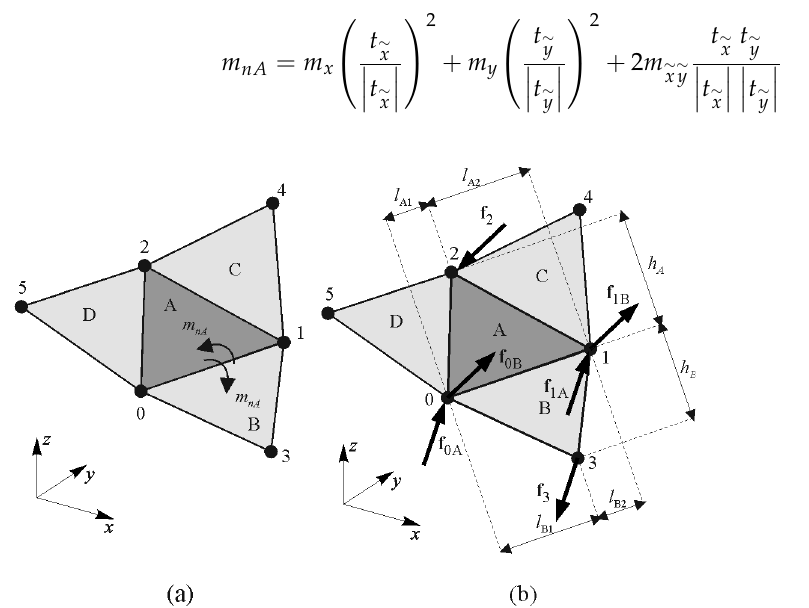
Figure 5. Forces resulting from bending carrying mechanism: ( a ) bending moment on the observed edge; ( b ) equivalent nodal forces.